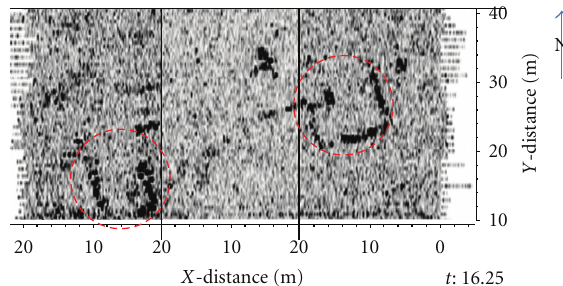
Figure 3: Time Slice at c. 16ns (about 68 cm) showing the extant archaeological remains. The wings of the villa are put into evidence by the red dashed circles.